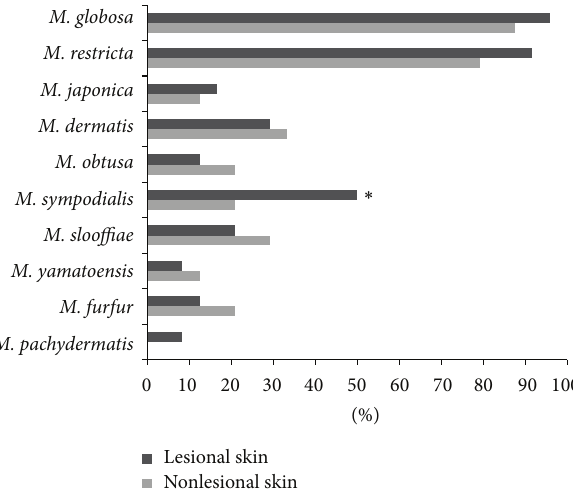
Figure 3: The relative quantity of each Malassezia species in the lesions compared with the nonlesional skin of the 24 patients. The 𝑦 -axis displays the increased prevalence of the species in the lesions compared with the nonlesional skin. ∗ 𝑃 < 0.05 , nonlesional skin versus lesional